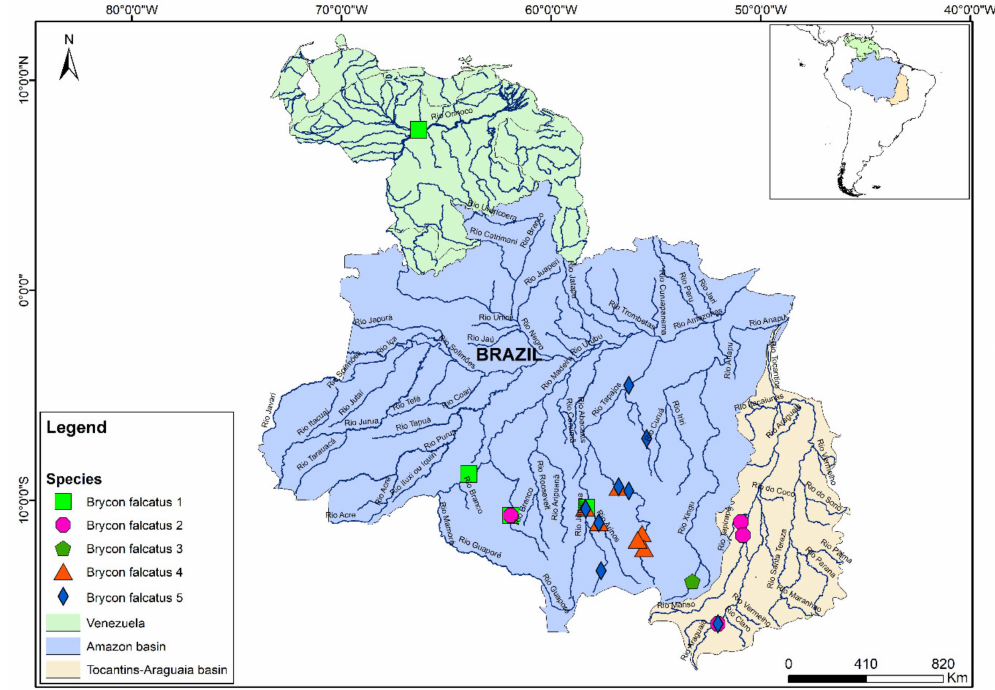
Figure 2. Distribution of the Molecular Operational Taxonomic Units (MOTUs) of Brycon falcatus identified in the molecular analyses.